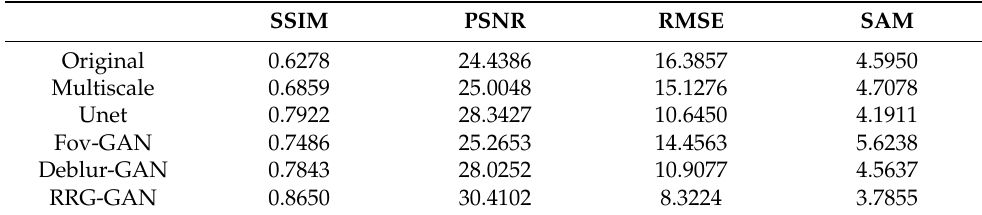
Table 1. Quantitative comparisons of restoring performance.